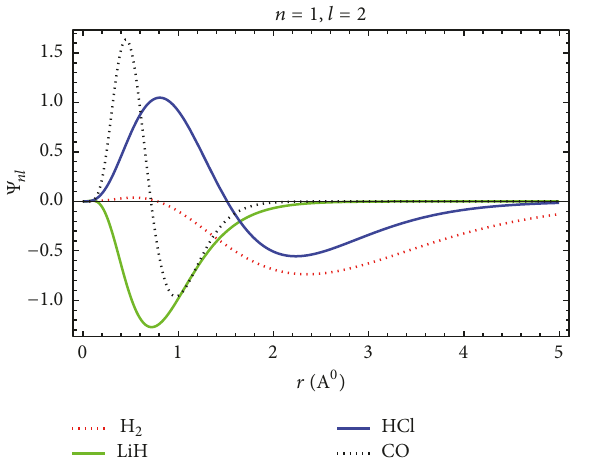
Figure 5: Wave function plot for the interaction potential with orbital angular quantum number 𝑙 = 2 .